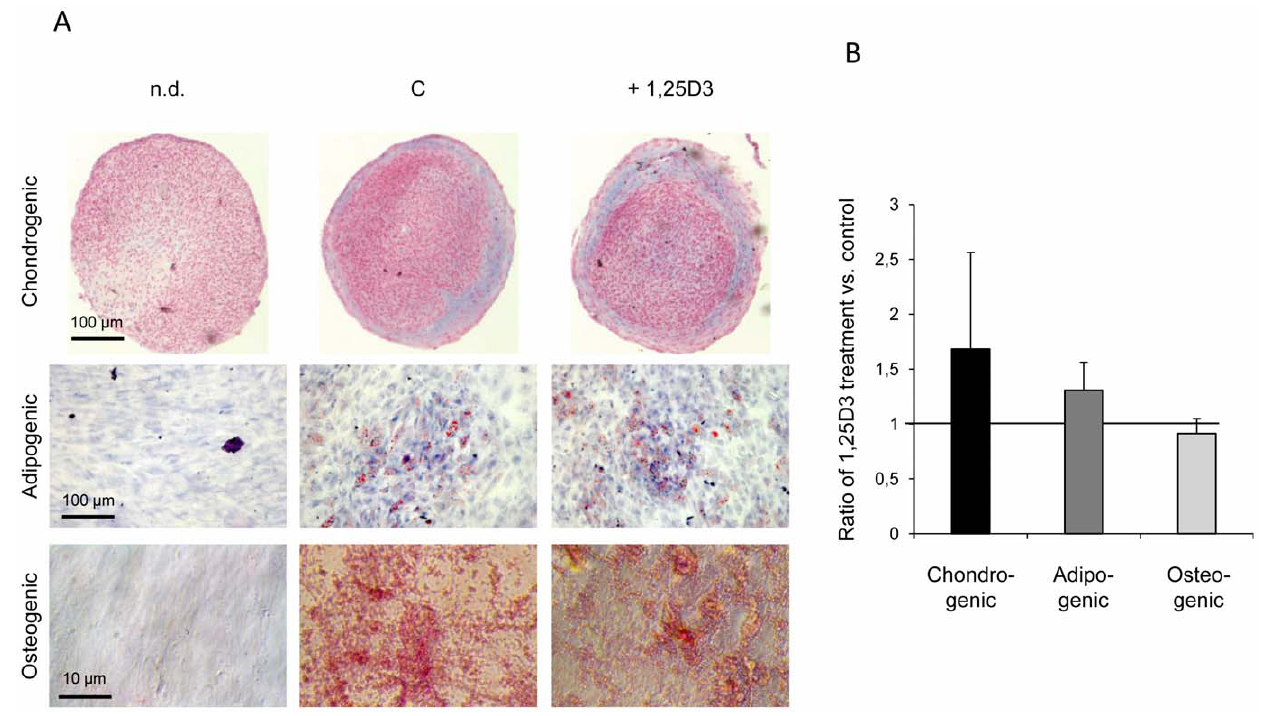
Figure 4. Trilineage differentiation capacity of 1,25D3 pretreated hMSC. A Chondrogenic, adipogenic and osteogenic differentiation of hMSC after 1,25D3 pretreatment over three passages. Alcian Blue staining of chondrogenic differentiated hMSC (upper panel), Oil Red O staining for intracellular lipid vesicles during adipogenic differentiation (middle panel) and Alizarin Red S staining of mineralized extracellular matrix after osteogenic differentiation (lower panel) are shown (n.d.=not differentiated; C=differentiated control; + 1,25D3=differentiated, cells pretreated for three passages with 1,25D3). The figure is representative for three independent experiments. The bar represents 100 m m and 10 m m, respectively as indicated. B Quantification of chondrogenic (black bar), adipogenic (dark gray bar) and osteogenic differentiation (light gray bar) after three passages 1,25D3 pretreatment in comparison to untreated cells. For each differentiation lineage the Fold Change was calculated by comparing the induction of differentiation of 1,25D3 pretreated cells with control cells. The results are shown as means of three independent experiments + SEM using three different preparations of hMSC. Each time 5 to 9 pictures of each differentiation experiment were analyzed using the AutMess tool of the software of AxioVision Rel.